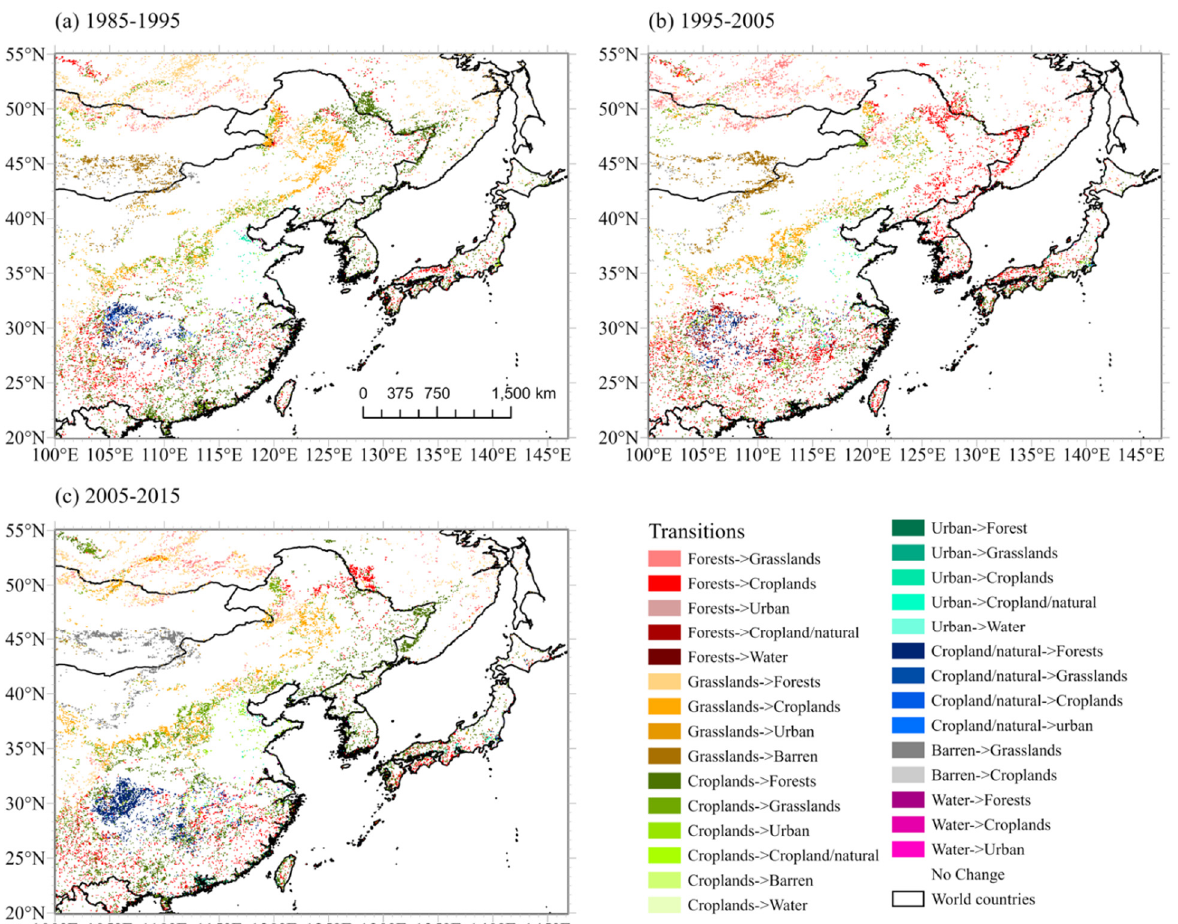
Figure 7. Transitions among the LCLU types in the EASM region for ( a ) 1985 to 1995, ( b ) 1995 to 2005, and ( c ) 2005 to 2015 (The forest class includes the evergreen broadleaf, deciduous needleleaf, deciduous broadleaf, and mixed forests as well as woody savannas and savannas, as presented in Table 6). In the Amur River basin in Russia, which is on the north-eastern side of the Songnen Plain, croplands were predominantly converted to forests (savannas) between 1985 and